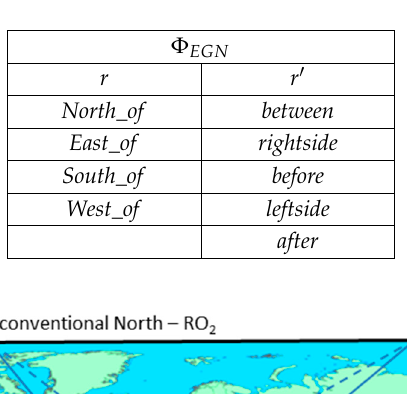
Figure 4. Geographic frame of reference.